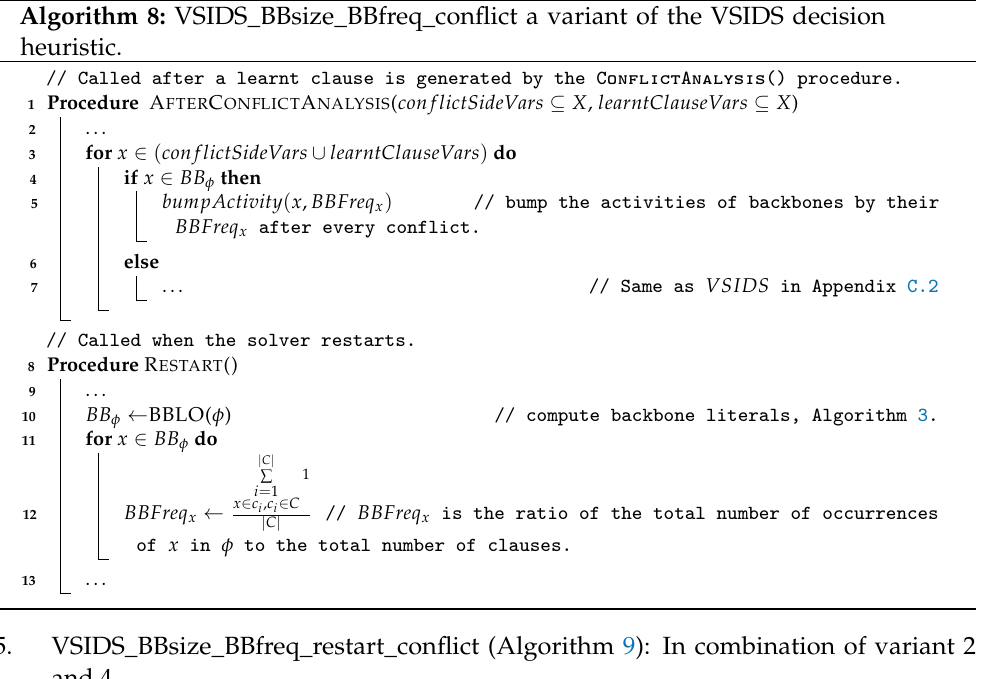
Algorithm 9: VSIDS_BBsize_BBfreq_restart_conflict a variant of the VSIDS deci- sion